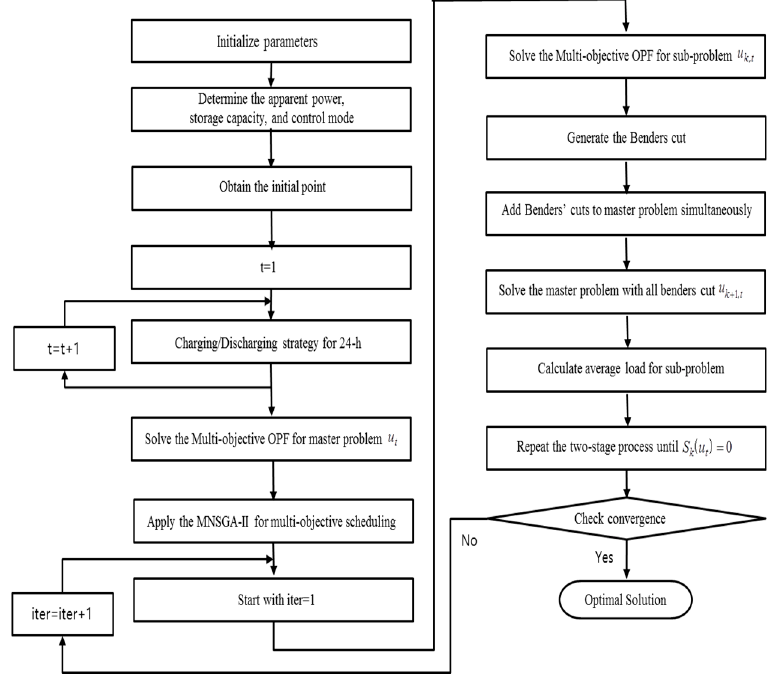
Figure 3. Flowchart of the proposed approach.